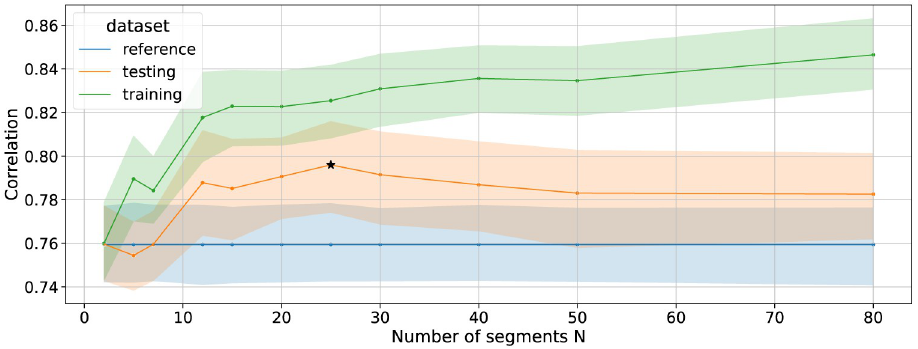
Fig 6. Influence of the number of regions on the correlation for training and testing. The best performance (marked with an asterisk) occurred for N = 25, with fewer segments the model was not flexible enough and with more segments the model started to